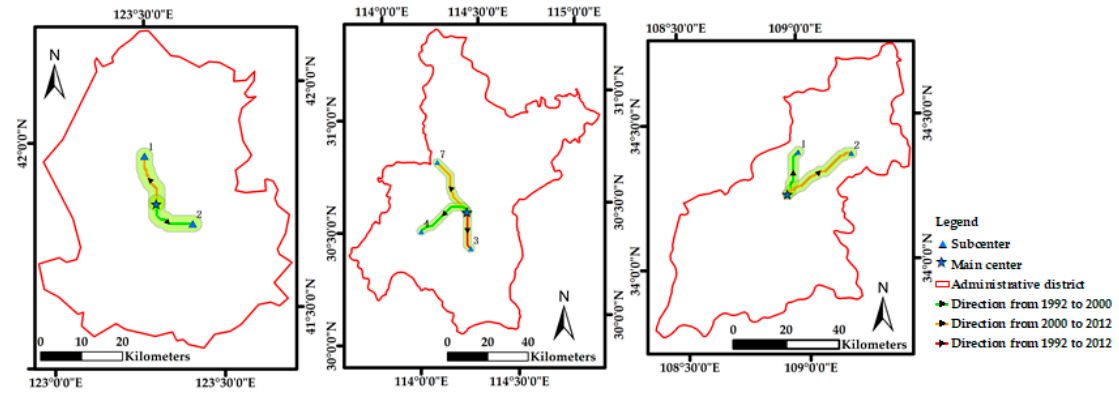
Figure 13. Spatial expansion directions.